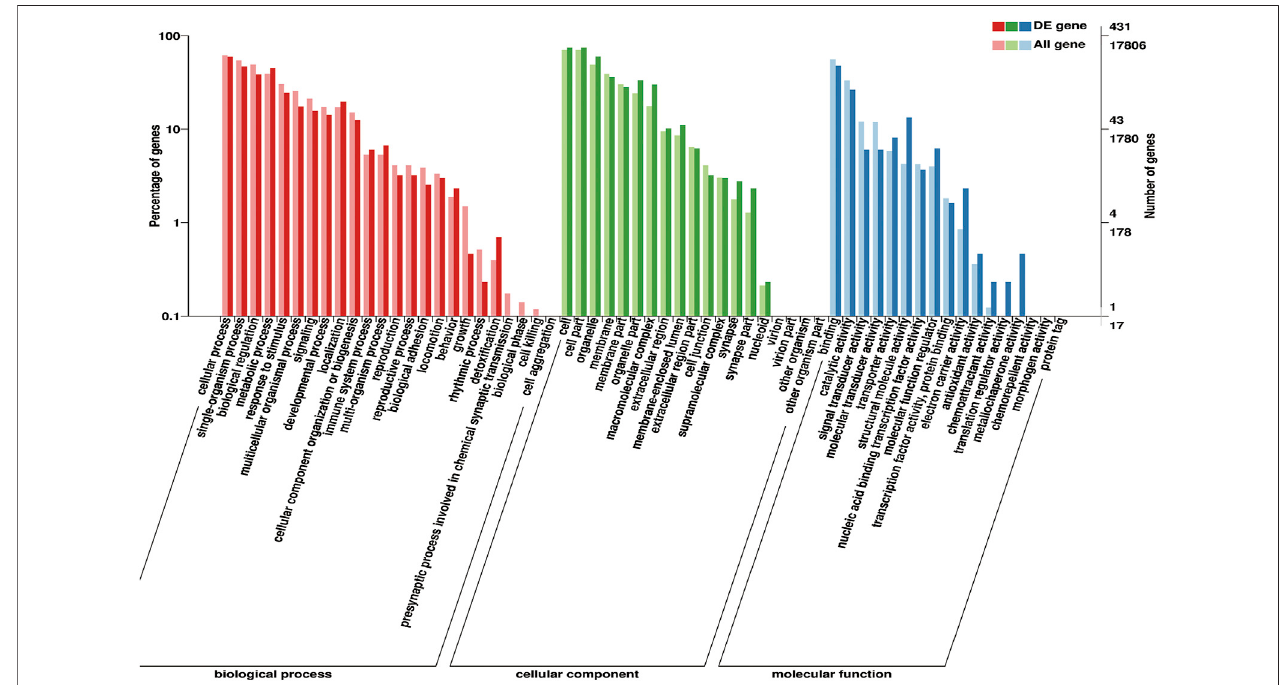
FIGURE 6 | Gene Ontology (GO) classi fi cation of 575 DEGs. GO terms are summarized in three main categories: cellular components, molecular functions, and biological processes.